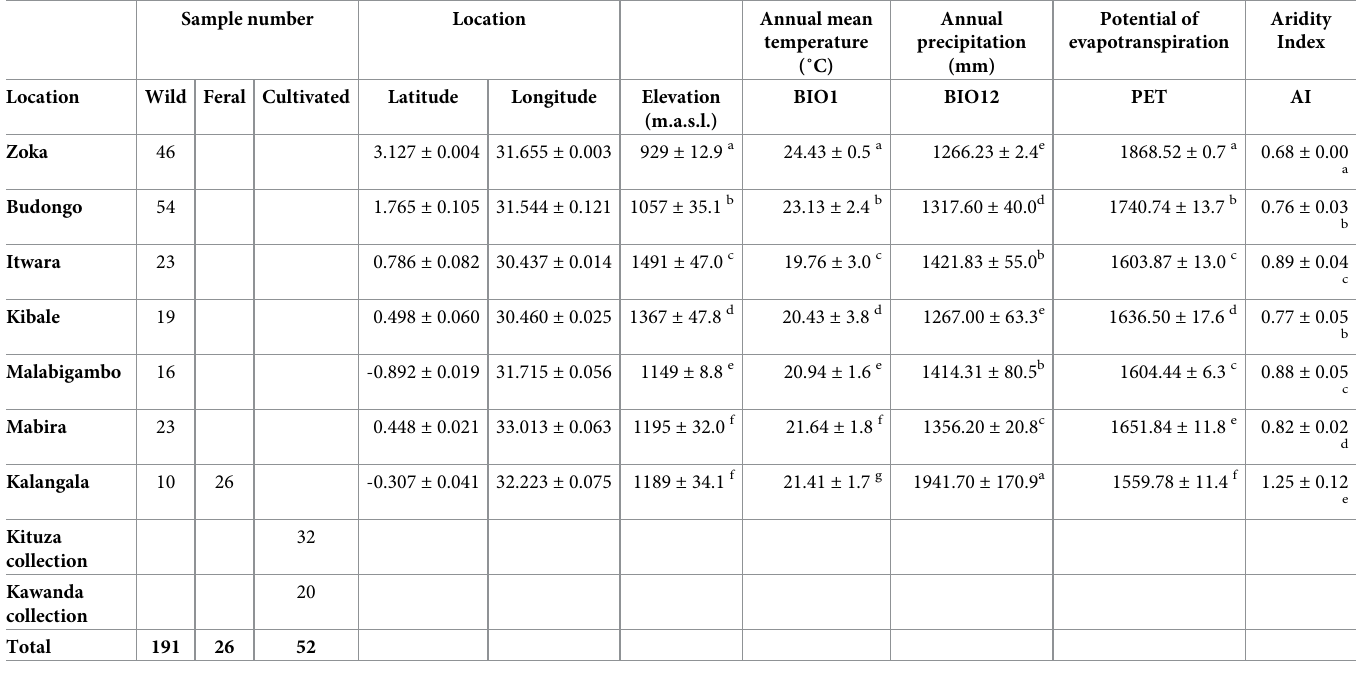
Table 1. Ugandan C . canephora sample origin. Mean and standard deviation of selected environmental variables across locations. All variables were significantly differ- ent across locations based on a one-way ANOVA (p-value < 2.2e-16). Pairwise t -test results between locations are also